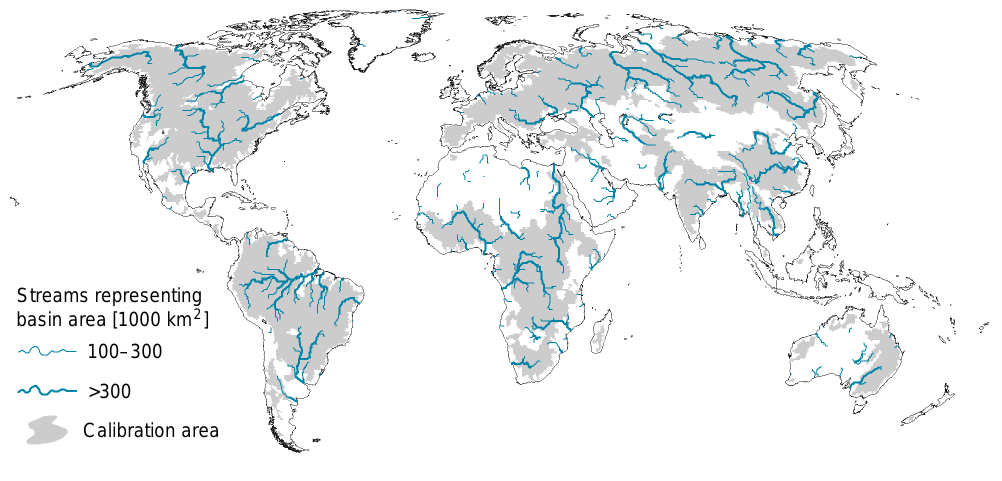
Figure 1. Global land area affected by WaterGAP 2.2 (ISIMIP2a) calibration (grey shading) against observed long-term average river discharge. Streamflow directions and flow accumulation are based on the drainage direction map DDM30 with 0.5 ◦ resolution (Döll and Lehner,